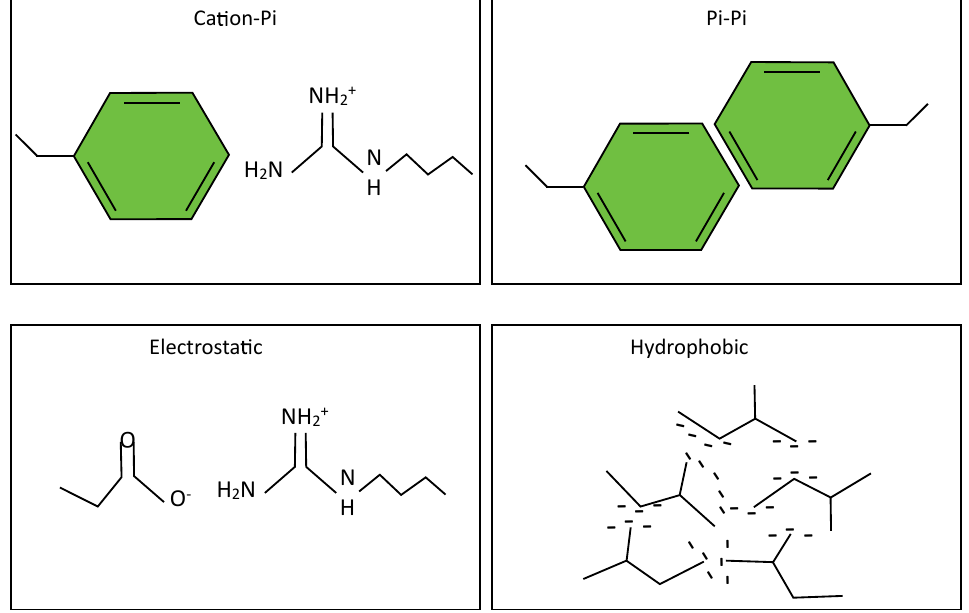
Figure 1. Biomolecular condensate − promoting features. The most common types of interaction among biomolecules that contribute to the formation of biomolecular condensate are illustrated. They include cation– π , π − π , electrostatic, and hydrophobic interactions.